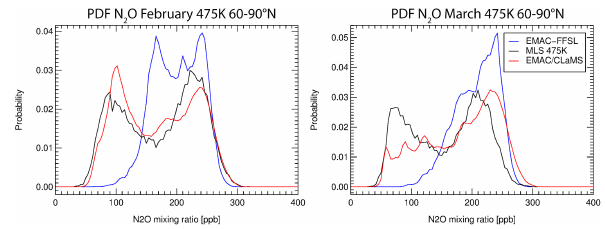
Figure 8. PDF at 475K for N 2 O mixing ratio from 60–90 ◦ N for the months February and March. Blue lines show EMAC-FFSL simu- lations, red lines EMAC/CLaMS simulations, and black lines rep- resent MLS